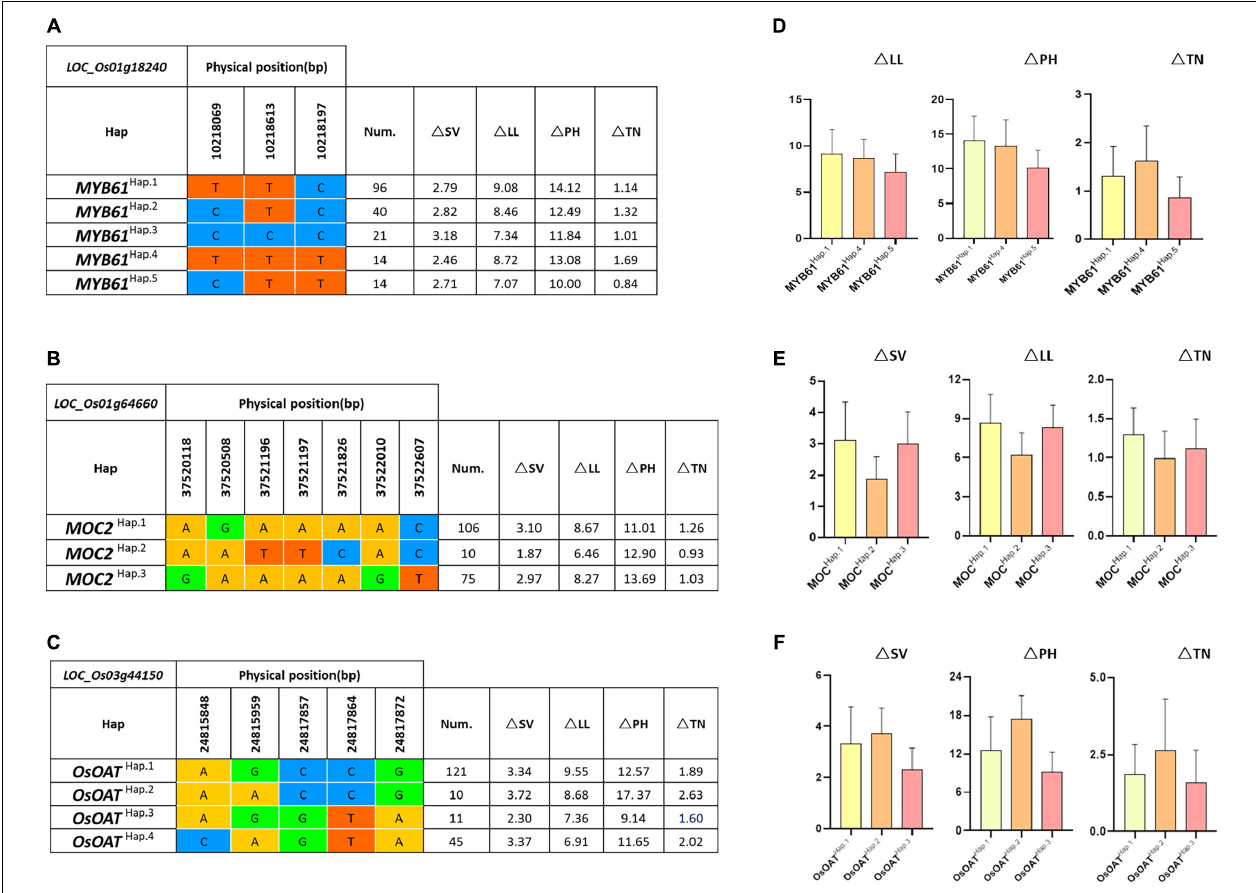
FIGURE 6 | Haplotype analysis of known genes MYB61 , MOC2 , and OsOAT . Gene structures (left) and the mean amount on (cid:77) SV, (cid:77) LL, (cid:77) PH, and (cid:77) TN of different haplotypes (right) of (A,D) MYB61 ( LOC_Os01g18240 ), (B,E) MOC2 ( LOC_Os01g64660 ), and (C,F) OsOAT ( LOC_Os03g44150 ). Num, number of accessions.